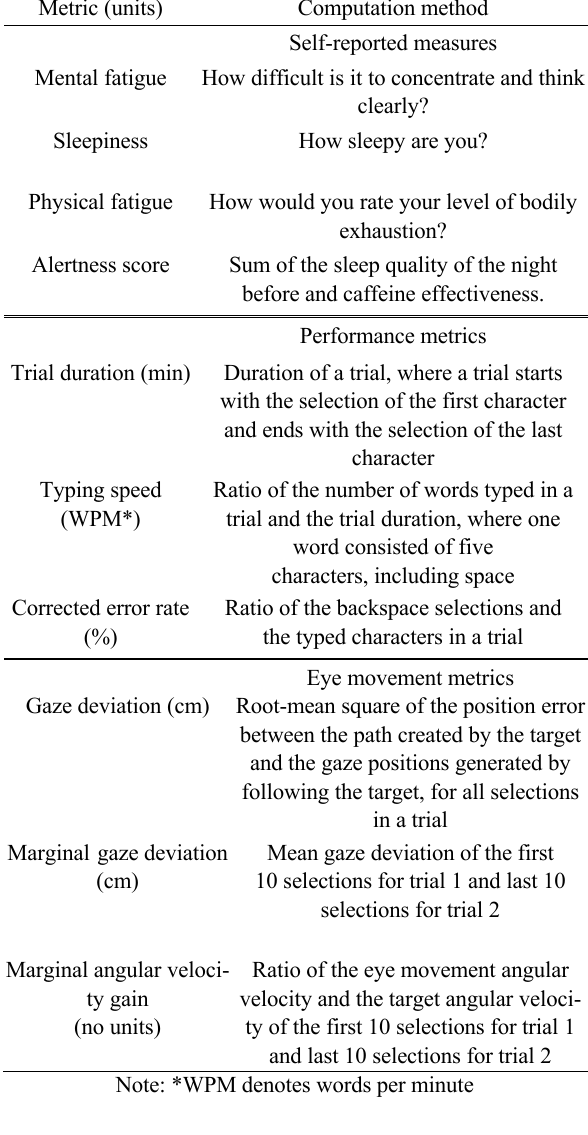
Table 1: Metrics used to analyze data, and their definitions Metric